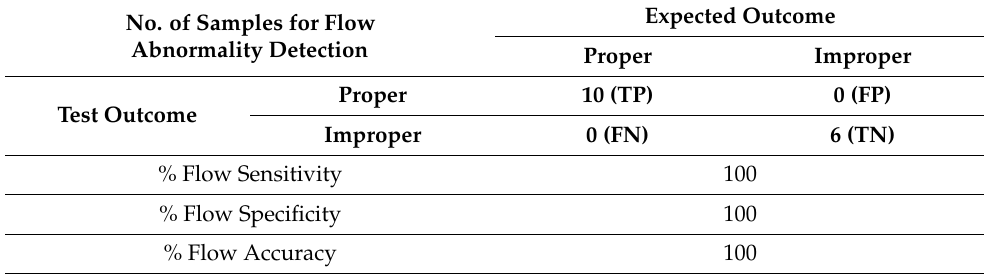
Table 3. Flow abnormality